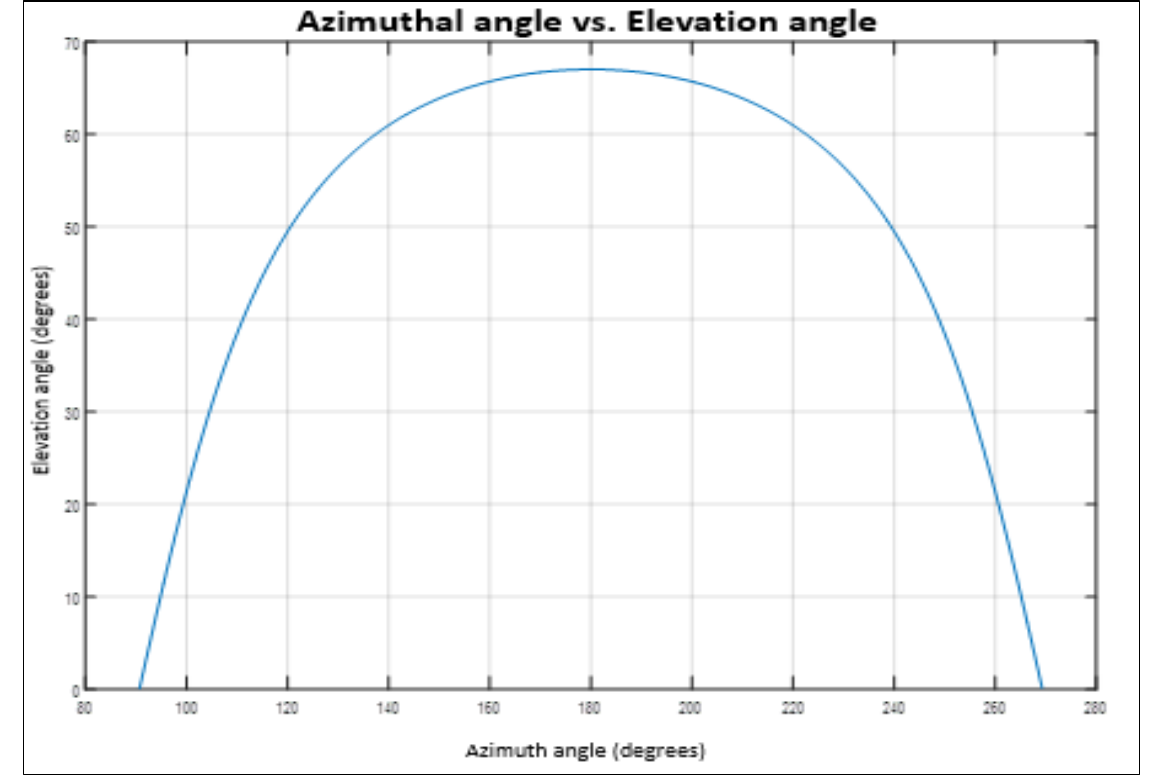
Figure 20: Behavior of the solar azimuth angle together with the solar elevation angle. Source: Authors, (2023).